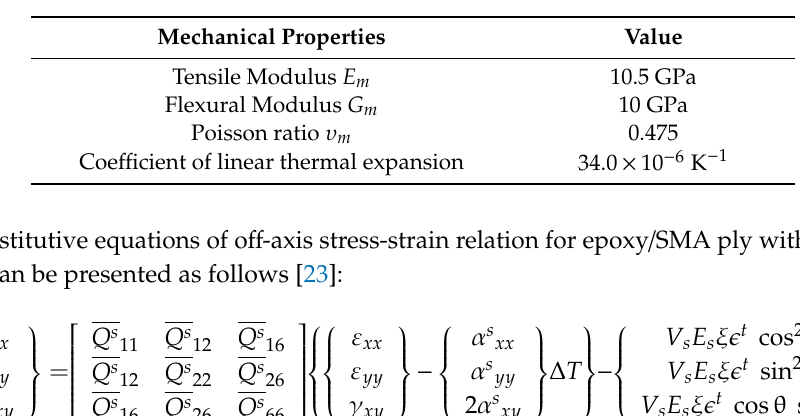
Table 3. Material properties of Epoxy Resin data from